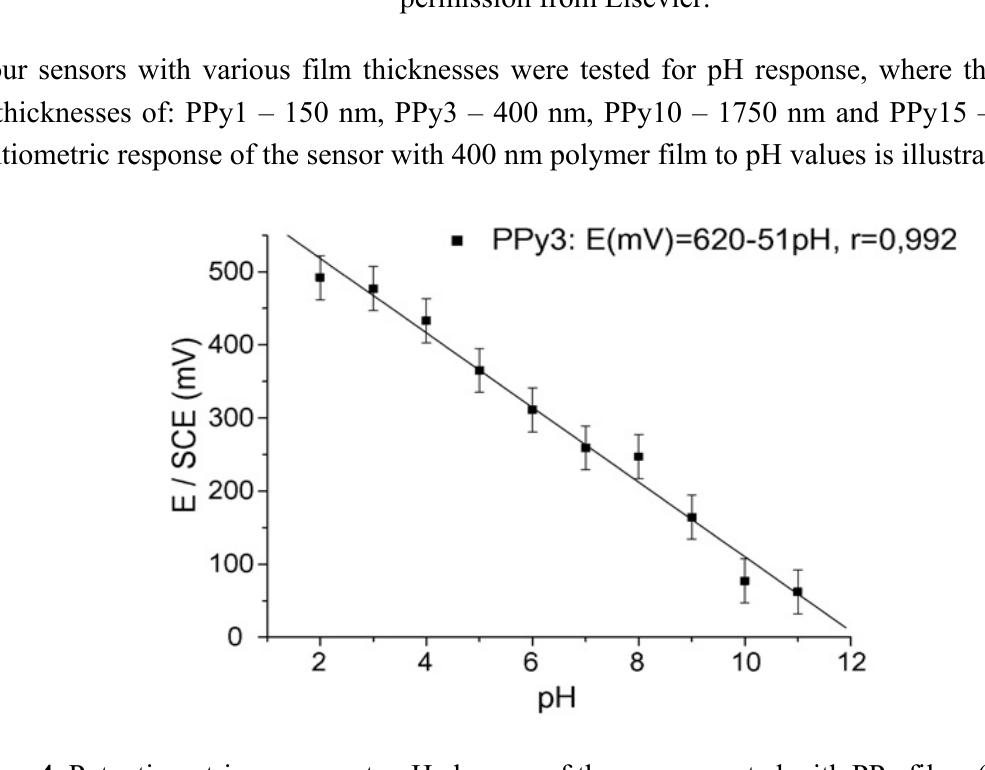
Figure 4. Potentiometric response to pH changes of the sensor coated with PPy films (average values are given after five measurements, bars correspond to standard